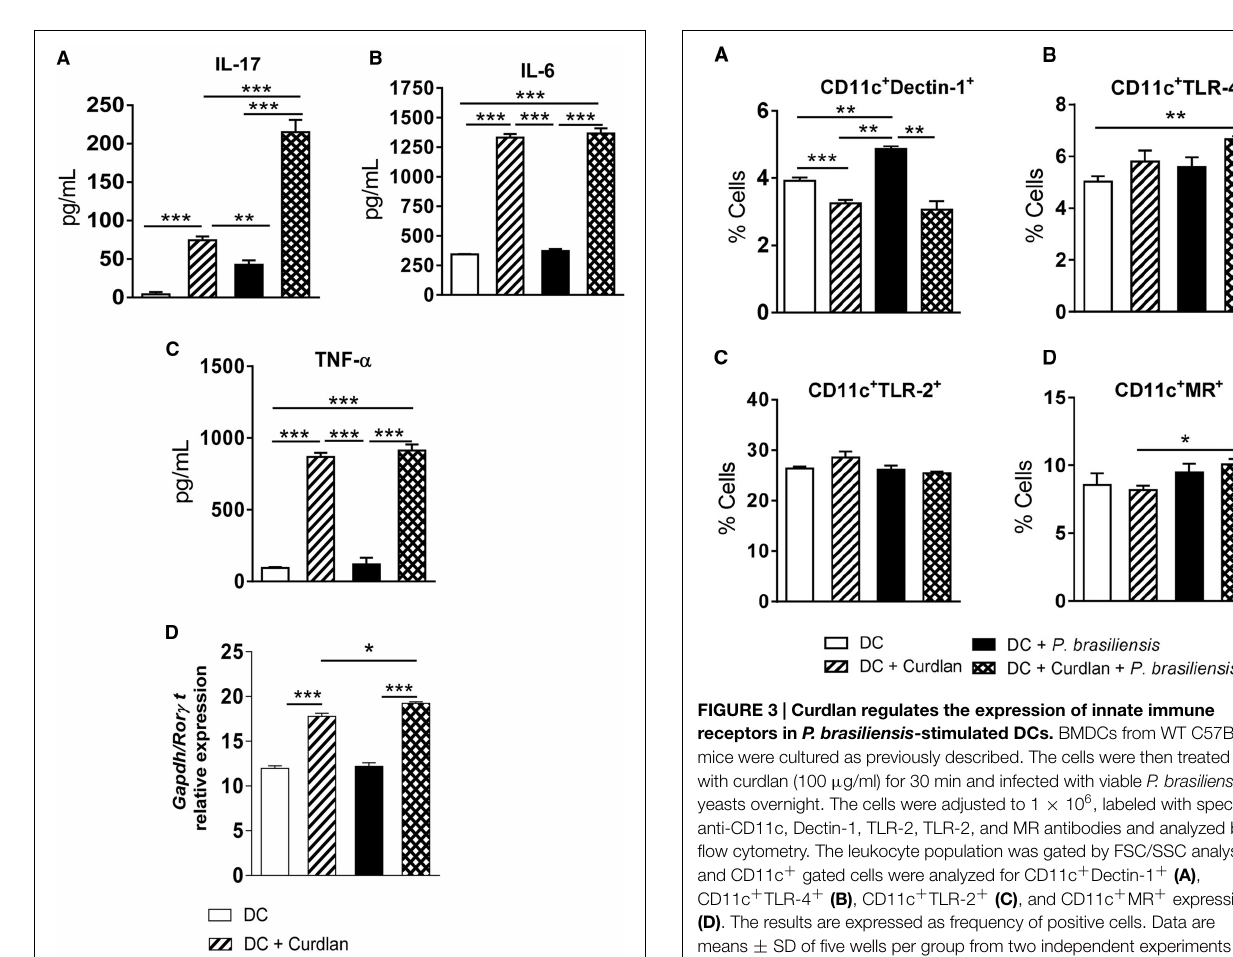
Thus,BMDCsfromWTandDectin-1 (cid:0) / (cid:0) micewereinfectedwith viable P. brasiliensis yeast cells for 2 h. In parallel, splenic lympho- cytes from uninfected WT and Dectin-1 (cid:0) / (cid:0) mice were previously labeled or not with CFSE and co-cultured with P. brasiliensis - infected DCs. After 5 days, lymphocytes were analyzed by flow cytometry. Lower proliferative responses of CD8 + T cells were observed in Dectin-1 (cid:0) / (cid:0) cultures in comparison with Dectin- 1-sufficient WT cultures. No differences in the proliferation of CD4 + T cells were observed between the two analyzed groups ( Figure4A ). Using Dectin-1 (cid:0) / (cid:0) cells, a lower frequency of CD4 + , CD4 + CD25 + , and CD8 + CD69 + T lymphocytes ( Figures 4B,C ) was observed when compared with WT cells. Furthermore, a lower frequency of IL-17-producing CD4 + and CD8 + T cells was expanded in Dectin-1 (cid:0) / (cid:0) cultures ( Figure 4D ). Combined, our data indicate that Dectin-1 is important for the proliferation of T cells and the induction of Th17/Tc17 cells by P. brasilien- sis -infected DCs. Furthermore, even in the absence of Dectin-1 expression, some Th17/Tc17 cells were expanded, indicating that other PRRs may be involved in this response. This led us to inves- tigate the cooperation among TLR-2, TLR-4, Dectin-1, and MR in the activation of T cells and differentiation of IL-17-producing